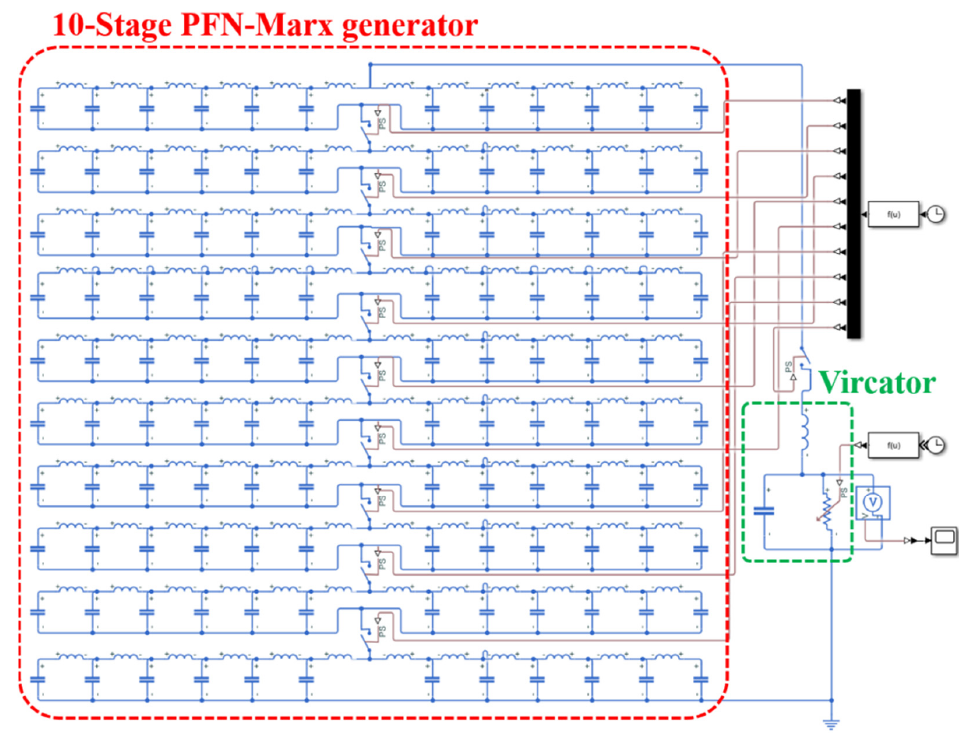
Figure 2. Circuit diagram of the 10-stage PFN-Marx generator.